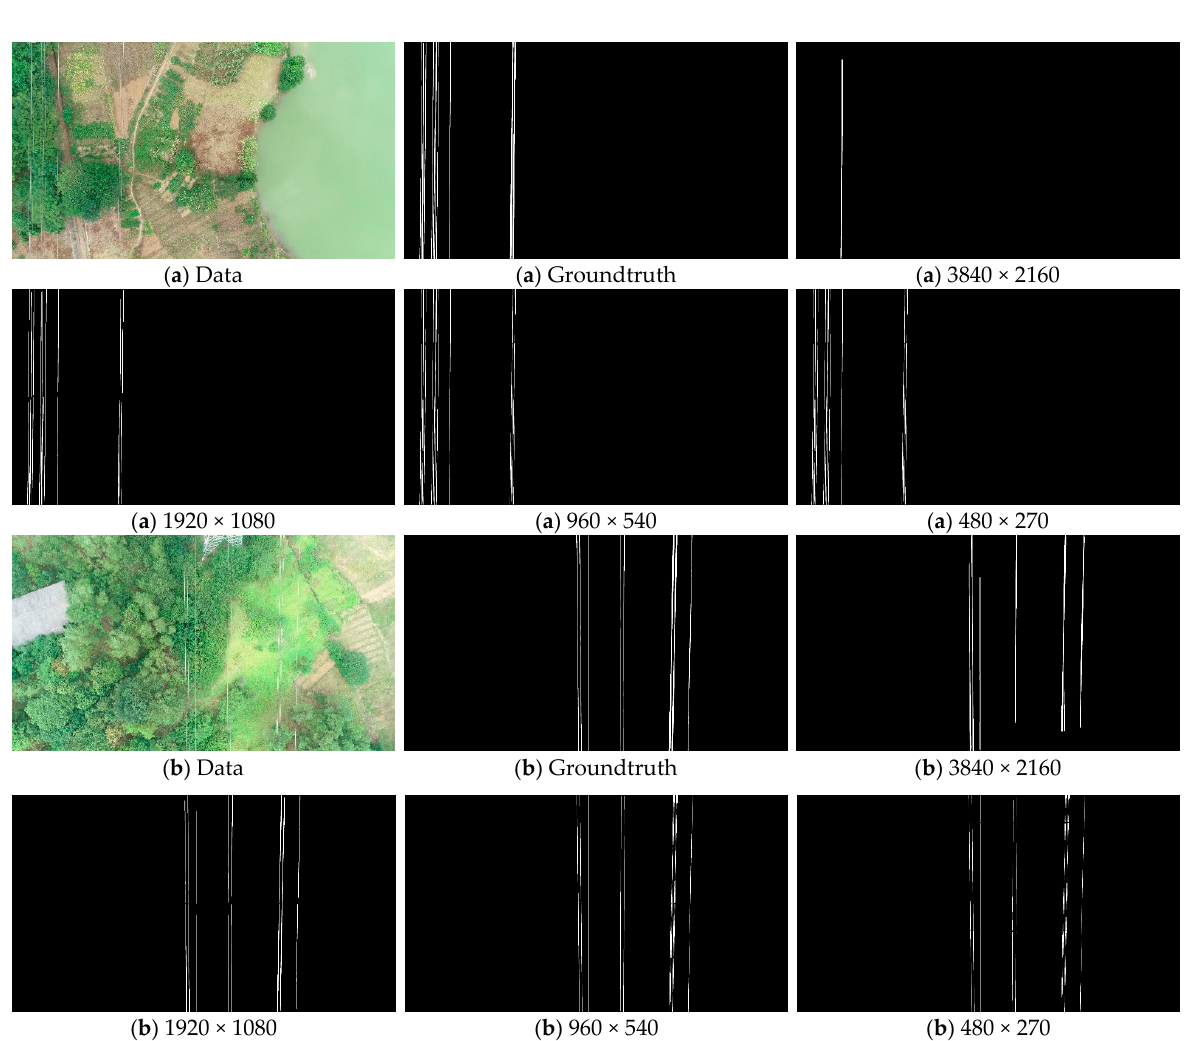
Table 5. The average of the performance parameters of the Mask RCNN and Mask RCNN + CDGFA extraction results when the block size of the test dataset is 960 ×